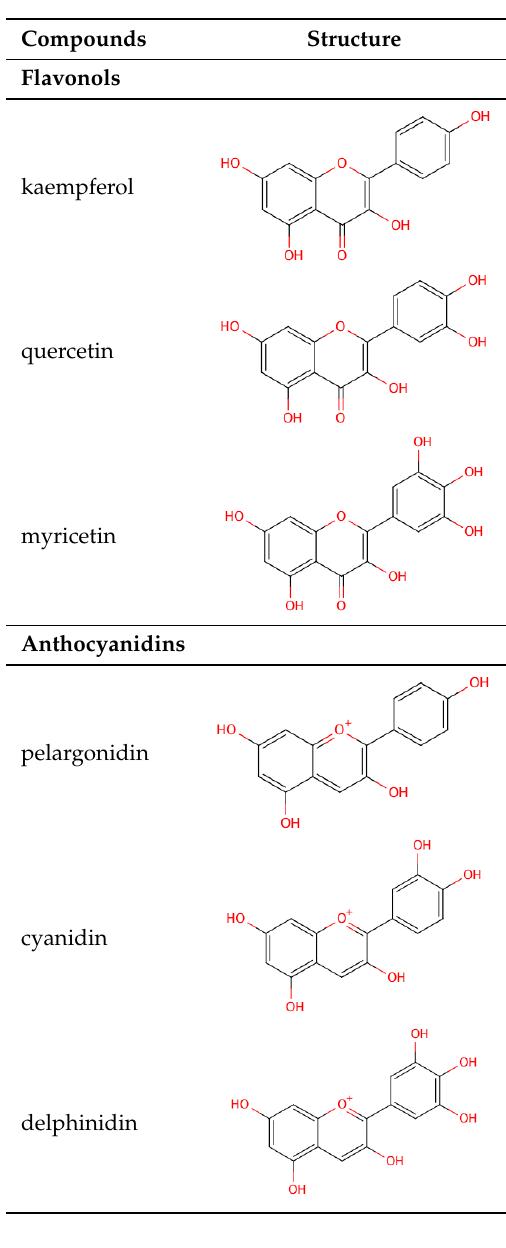
Table 1. List of flavonoids by name, chemical structure. The structures shown are ordered according to the number of hydroxyl substituents present in ring